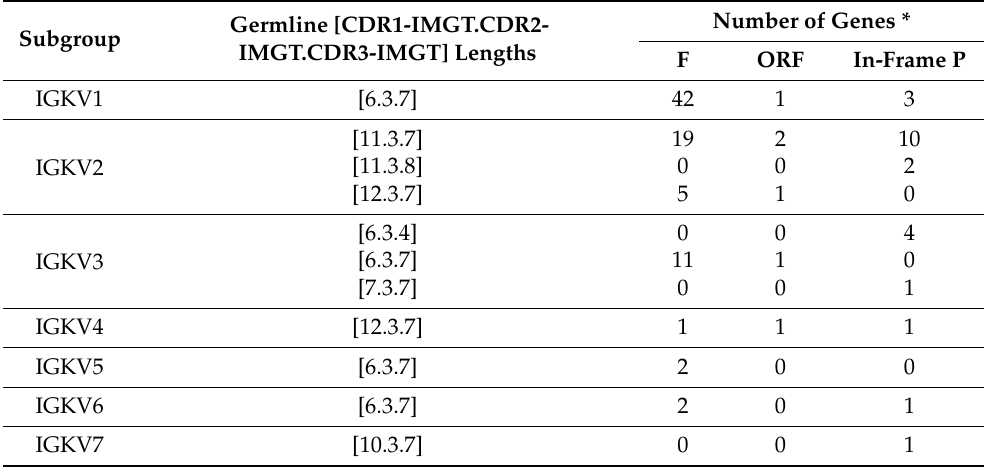
Table 14. CDR-IMGT lengths distribution in each IGKV subgroup.